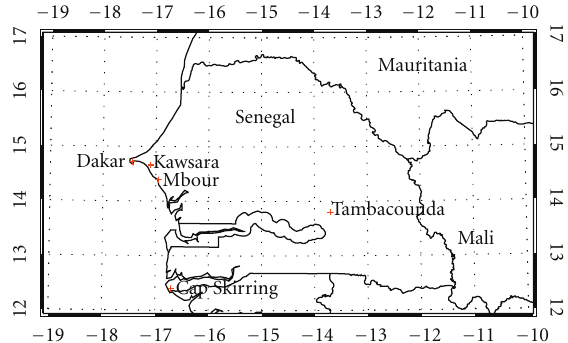
Figure 1: Map of cities and villages in Senegal where meteorological data relevant to this study was obtained.